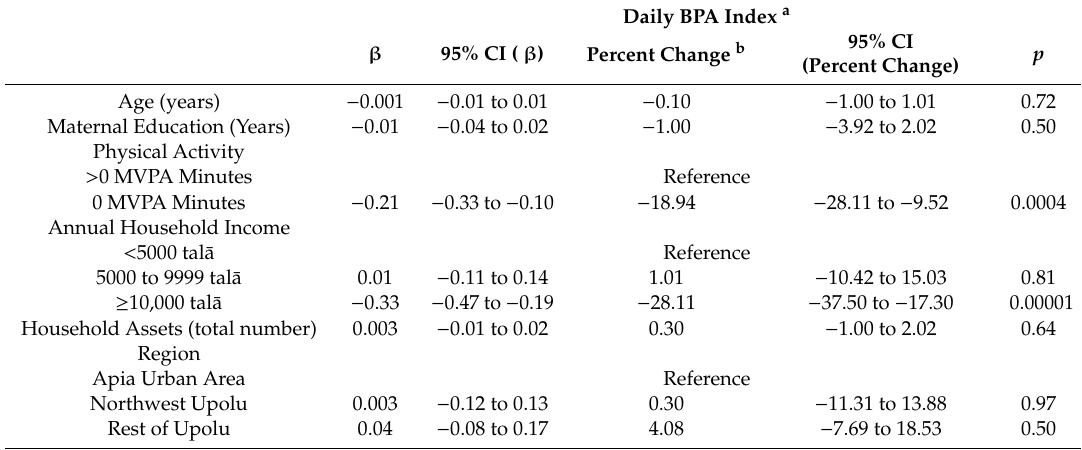
Table 3. Results of multiple linear regression examining associations between participant characteristics and log-transformed (base e) daily BPA index in mothers ( n = 351).